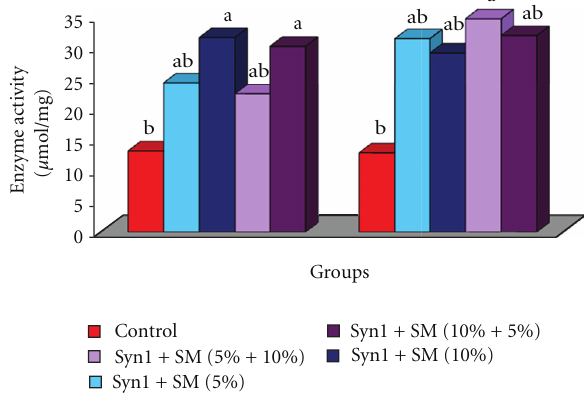
Figure 5: E ff ect of feeding prebiotics and soybean meal on cecal bacterial enzyme activities. (a) β -glucosidase. (b) β -glucuronidase activity ( μ mol/mL) in F344 male rats. Abbreviations: SM: soybean meal. ab Bars with same letter are not significantly di ff erent using Tukey’s studentized range test ( P ≤ 0 .